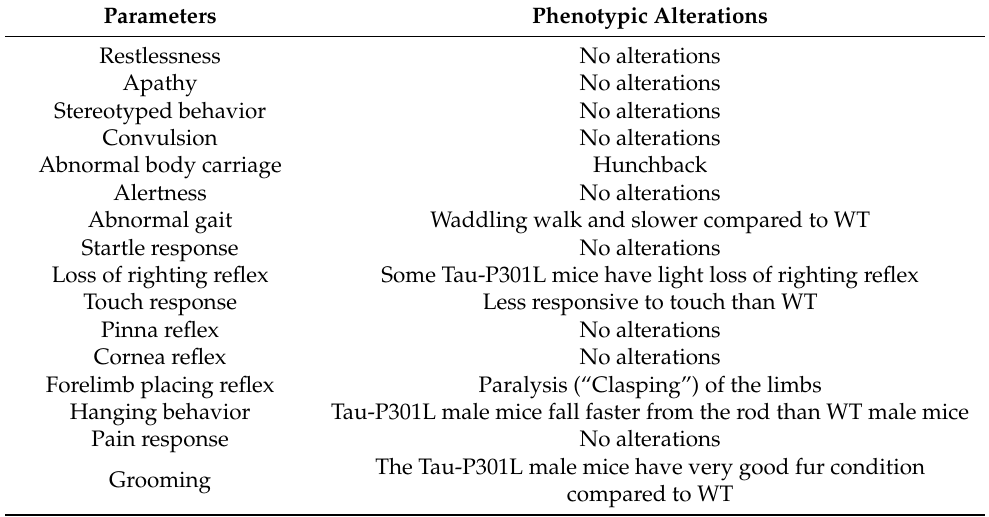
Figure 1. Tau-P301L mice develop olfactory deficits in the habituation/dishabituation olfactory test at 6 months of age. The bacon aroma was presented six times to the mice, the cheesecake and hazelnut aroma were presented afterwards. The sniffing (exploration) time was evaluated as the time the mouse placed the nose on the box with aroma-sprayed cotton. Tau-P301L male mice ( n = 12) smelled the new aroma less (cheesecake and hazelnut) compared to the age-matched WT male mice ( n = 12), but this was not observed in the females ( n = 7). The two-way ANOVA was used as statistical analysis. *: p < 0.05 and **: p < 0.01 compared to the age-matched WT. Data are given as mean ± SEM. Table 2. Tau-P301L mice showed phenotypic alterations in different evaluated parameters in the SHIRPA test starting at 4 months of